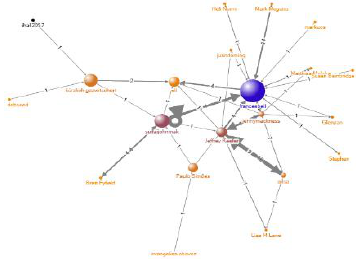
Figure 7. Social network of the topic “orientation myself in the